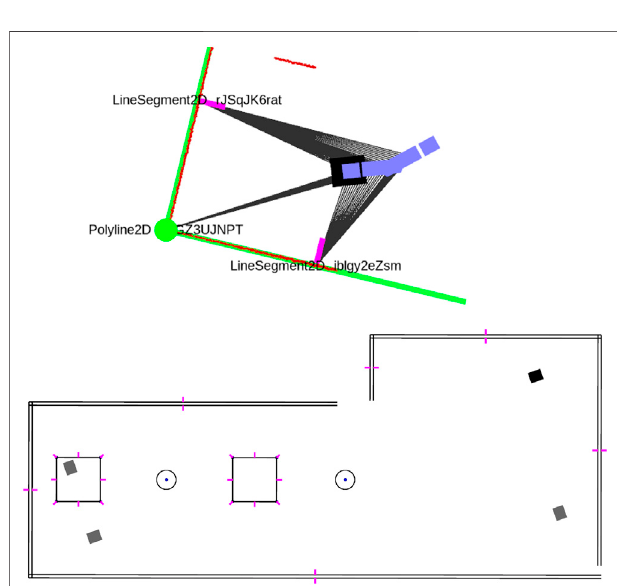
FIGURE 4 | The global map hypotheses (bottom) corresponding to a local map (top). Based on the local features in that fi gure, four possible map poses are shown (not all hypotheses permit showing a unique pose). Note that walls have been modeled by double line segments with visibility normals visualized by small purple segments. The labels of the global map have been omitted in this example.